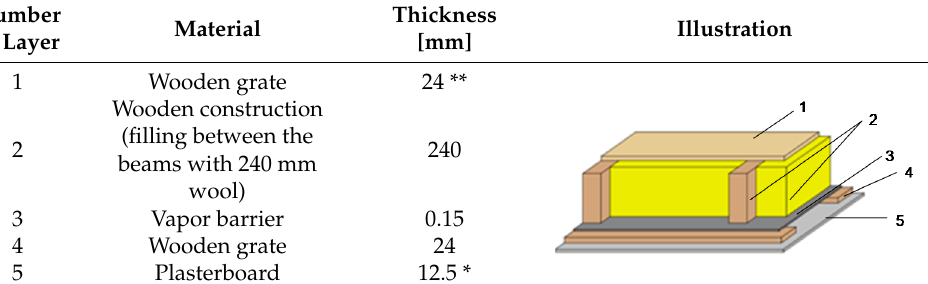
Table 3. Ceiling above the attic, Wolf system.